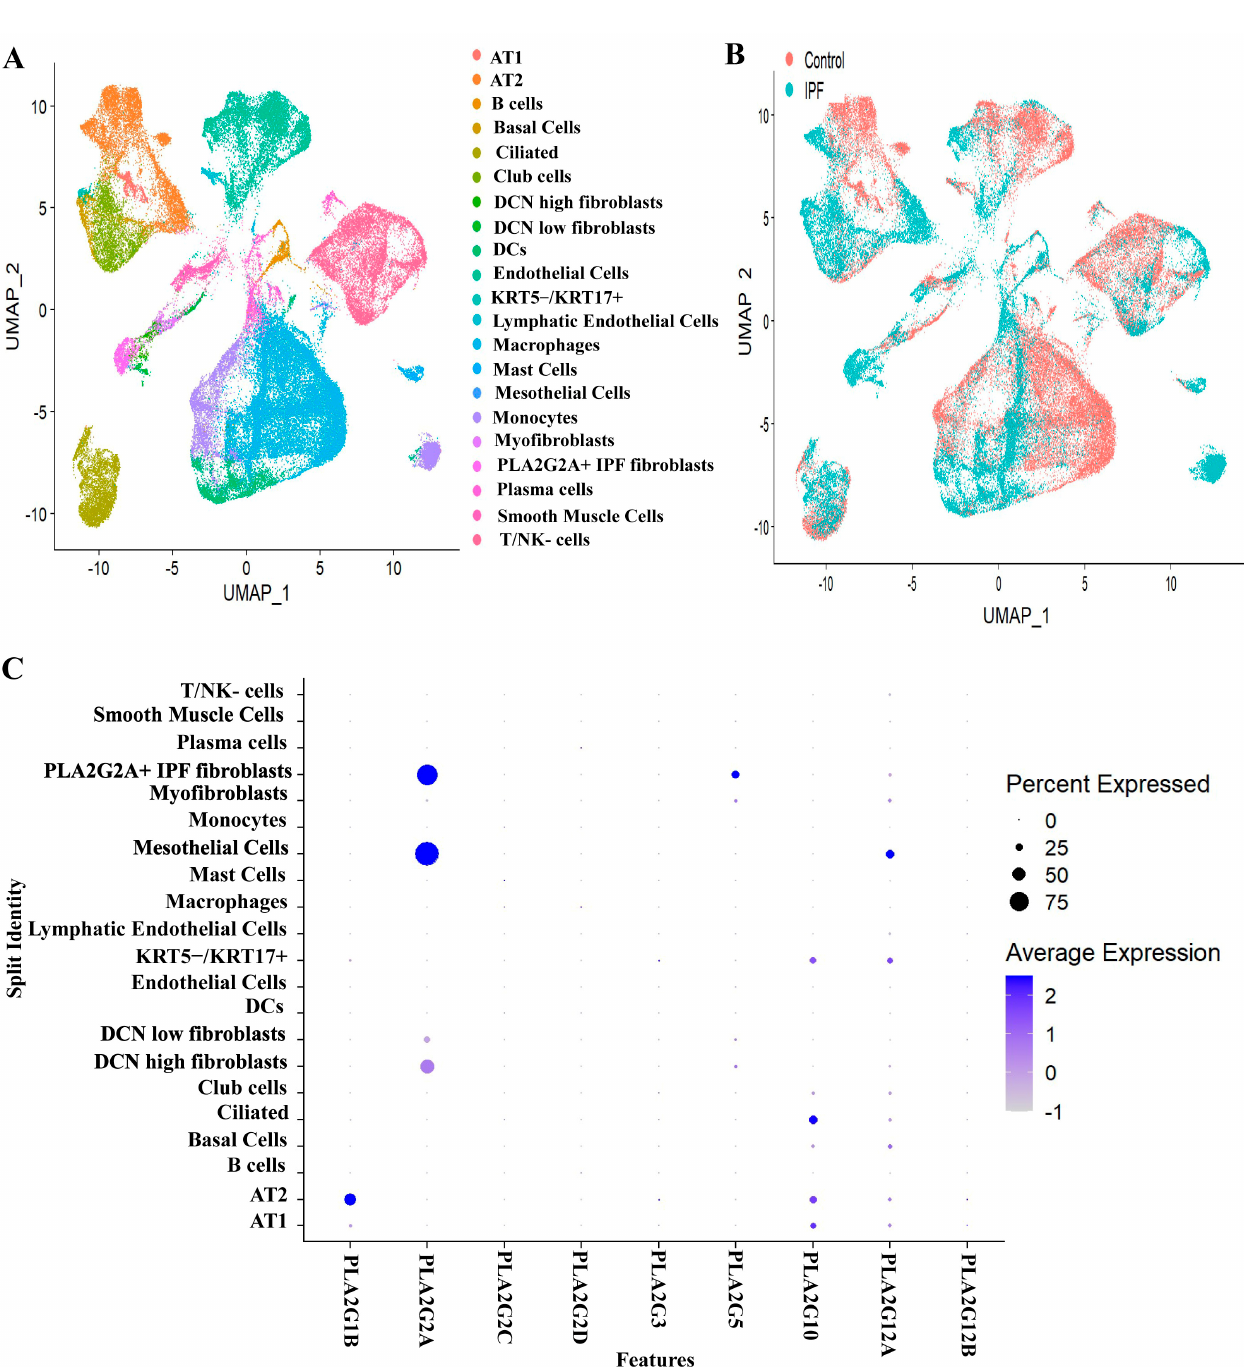
Figure 1. Analysis of single cell RNA seq. data reveals the expression profile of various sPLA2 in data set A (GSE135893). ( A ) Uniform Manifold Approximation and Projection (UMAP) after analyzing and annotating the clusters; Single cell RNA seq data from 8 control (healthy individuals) and 8 IPF patients, using Seurat as described by Habermann et al., showing various cell types. ( B ) UMAP plot showing cells, colored by their origin either from control or IPF patients ( C ) Dot plot showing cellular distribution of PLA2G1B, PLA2G2A, PLA2G2C, PLA2G2D PLA2G3, PLA2G5, PLA2G10, PLA2G12A and PLA2G12B in lung. (Circle size indicates percentage of cells expressing the given gene; intensity of blue color indicates extent of